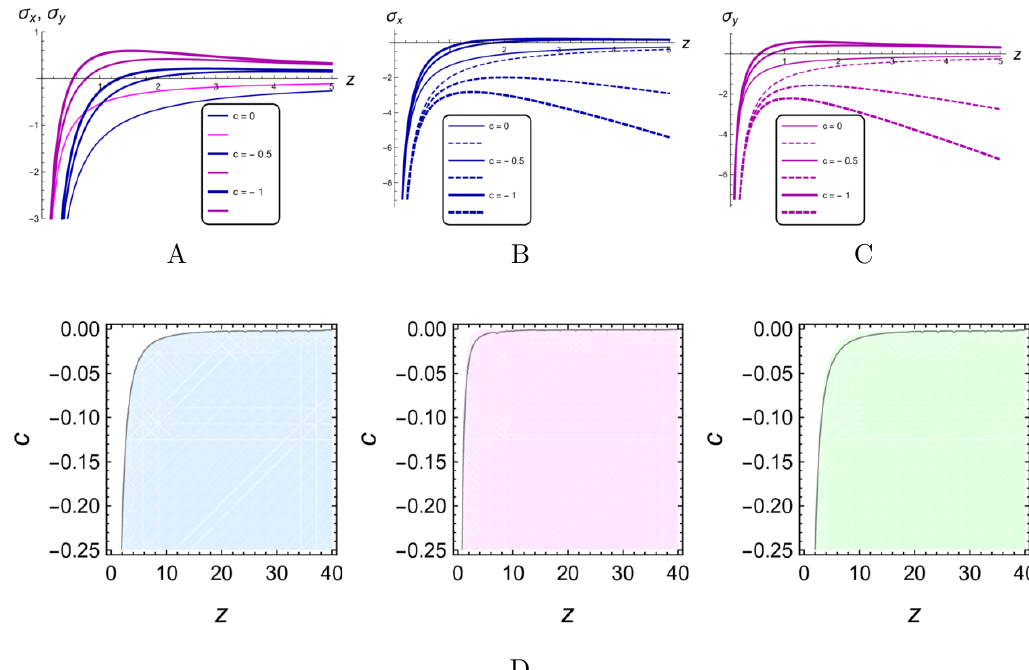
Figure 32 . Functions (cid:27) x ( z; c; (cid:23) ) (blue lines) and (cid:27) y ( z; c; (cid:23) ) (magenta lines) for di(cid:11)erent c with dilaton contributions (solid lines) and without them (dashed lines) together (A) and separately (B, C); solutions to (4.9) (boundary of blue and white areas), to (4.10) (boundary of magenta and white areas) and for the isotropic case (boundary of green and white areas)